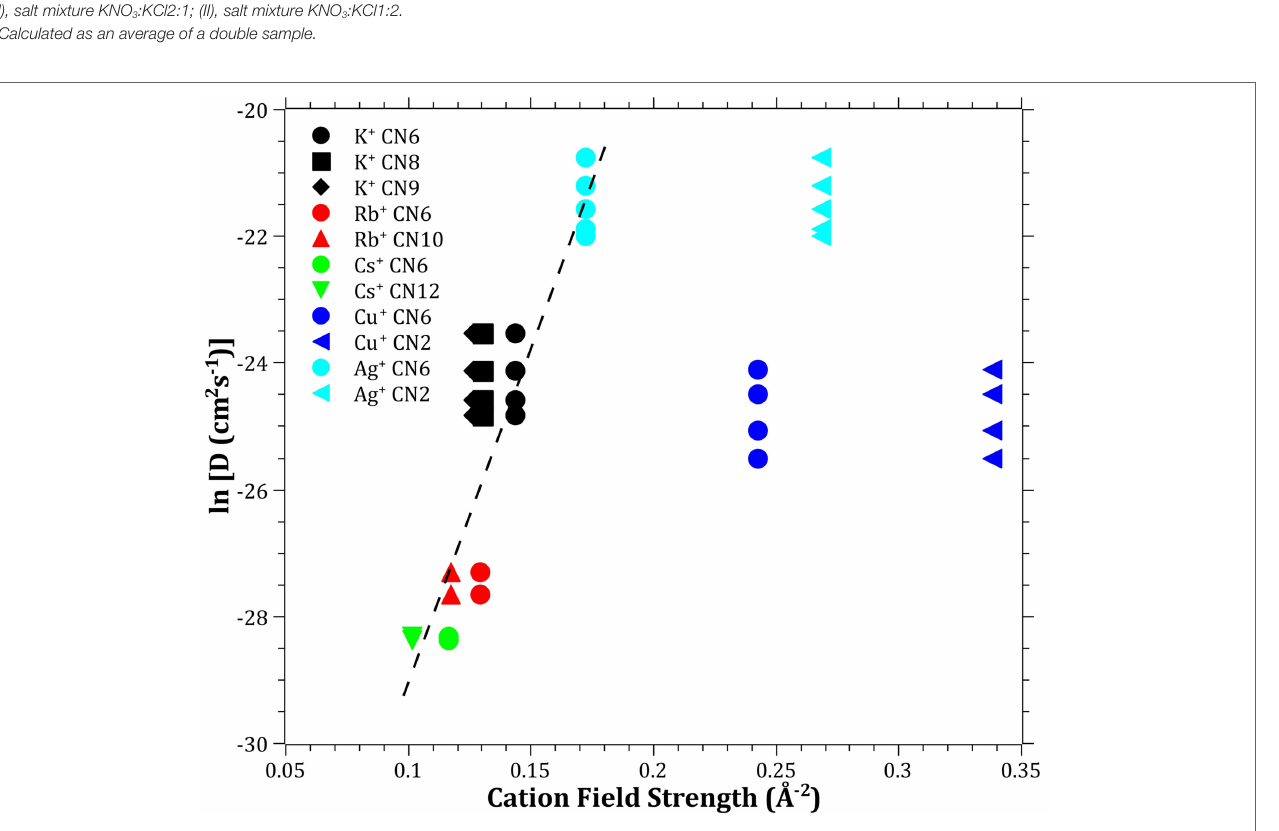
FiGUre 4 | Logarithm of the effective diffusion coefficient vs. cation field strength . Data calculated from ionic radii data (Shannon, 1976) according to Eq. 3 (Dietzel, 1942). The dashed line is a guide to the eye.